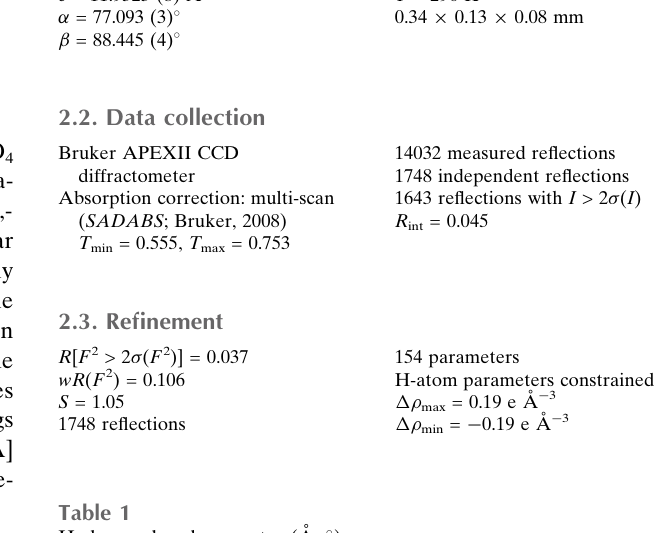
Hydrogen-bond geometry (A˚ , (cid:2)